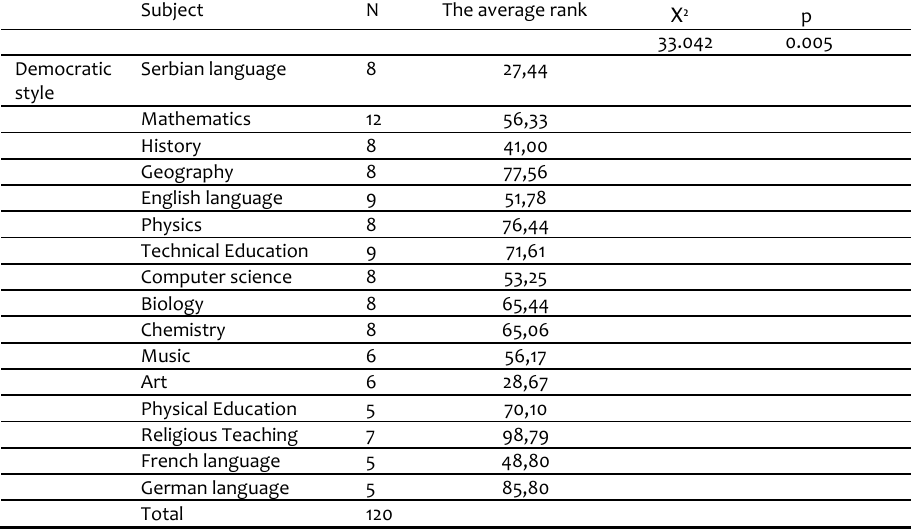
Table 1. Differences in teachers' assessments of democratic work style